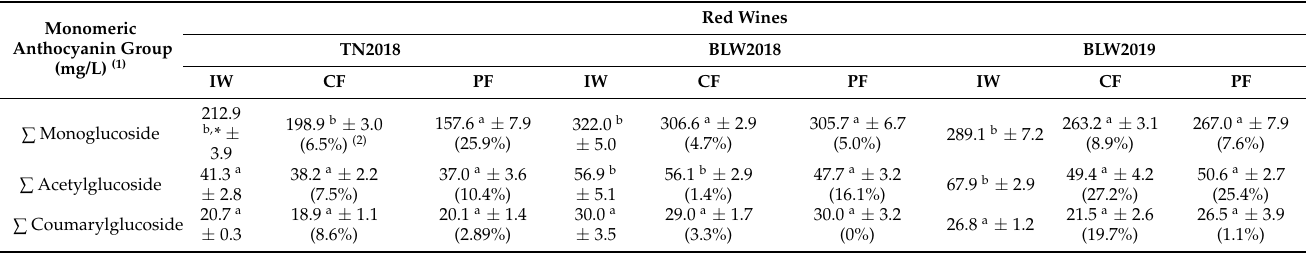
Table 3. The impact of the two different filtration techniques on the monomeric anthocyanin groups for the three red wines